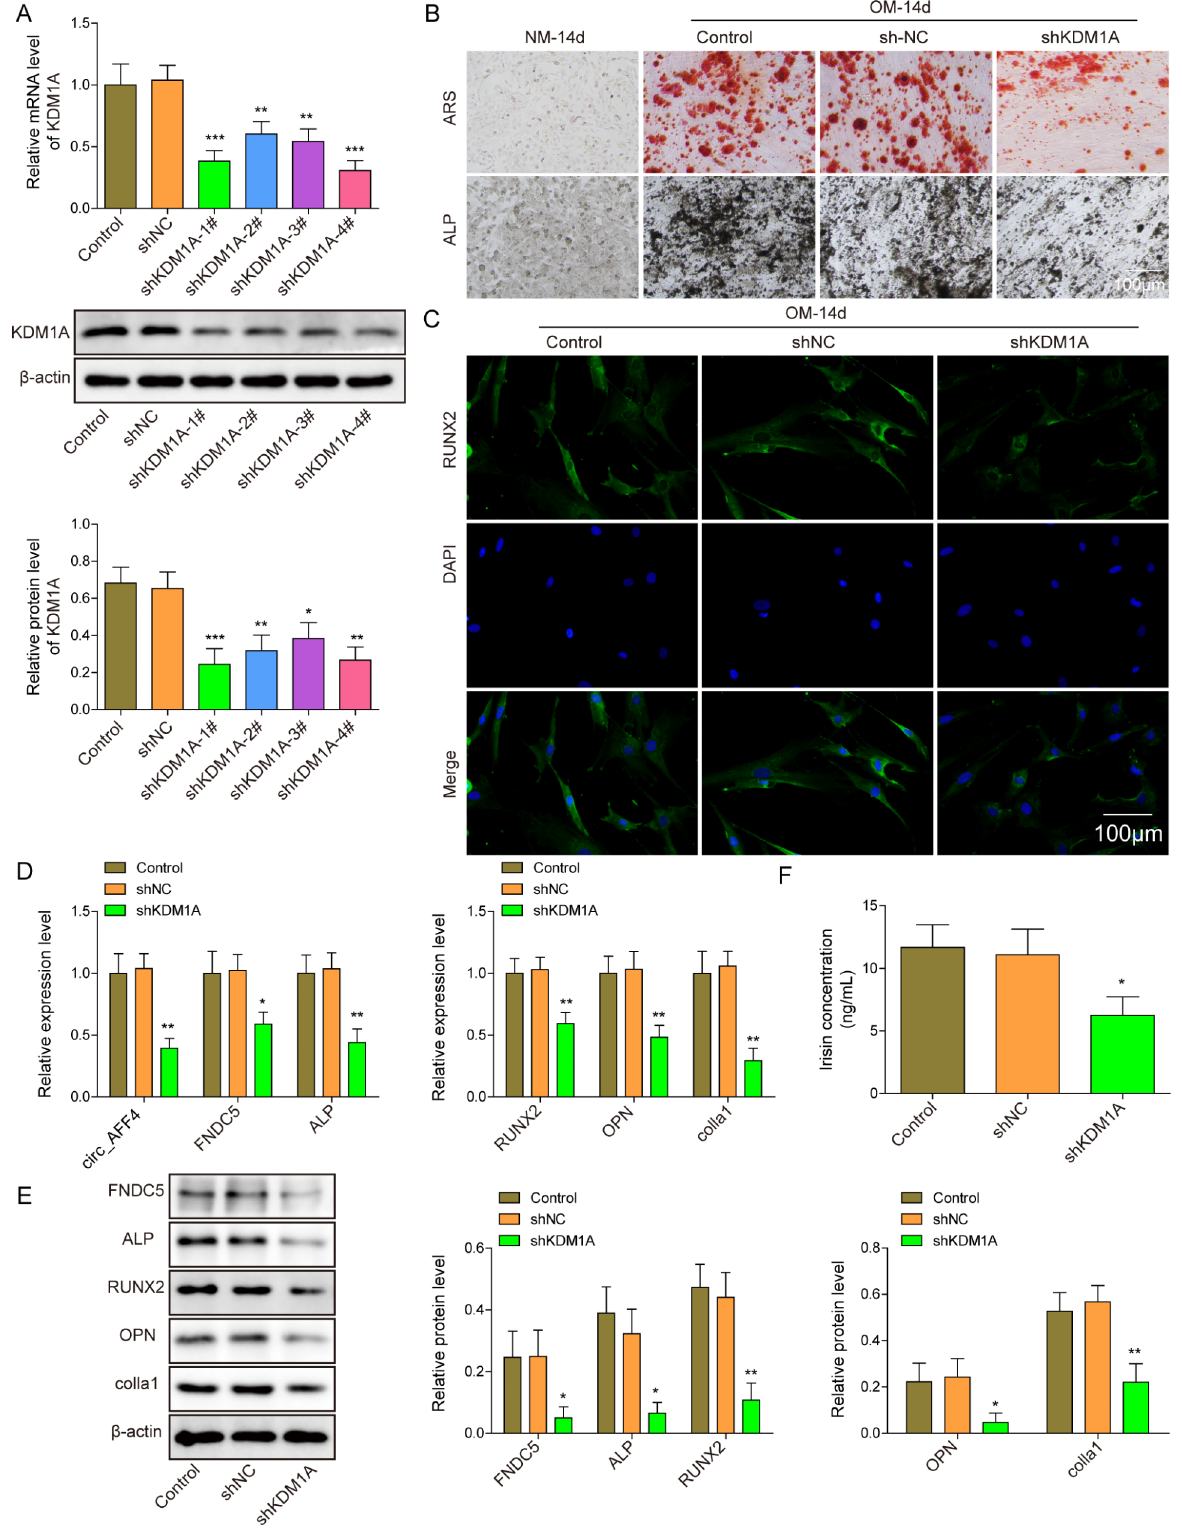
Fig. 5 Knockdown of KDM1A suppresses osteogenic differentiation of BM-MSCs ( A ) BM-MSCs were transfected with shKDM1A_1–4# or shNC and the expression level of KDM1A in shKDM1A_1–4# or shNC transfected BM-MSCs was detected using western blot. BM-MSCs that were transfected with shKDM1A or shNC were cultured in OM or NM for 14 days. Afterward, different assays were performed to assess the osteogenic differentiation. ( B ) Representative images of ARS and ALP staining. Scar bar = 100 μm. ( C ) Representative RUNX2 immunofluorescence staining image. Scar bar = 100 μm. Gene and protein expression of osteogenic markerslivergent, ALP, OPN, RUNX2 and Colla1, and circ_AFF4, FNDC5 were detected by ( D ) RT-qPCR and ( E ) western blot. ( F ) ELISA detected Irisin expression. * p < 0.05, ** p < 0.001 and *** p < 0.001. Each experiment was performed at least three times